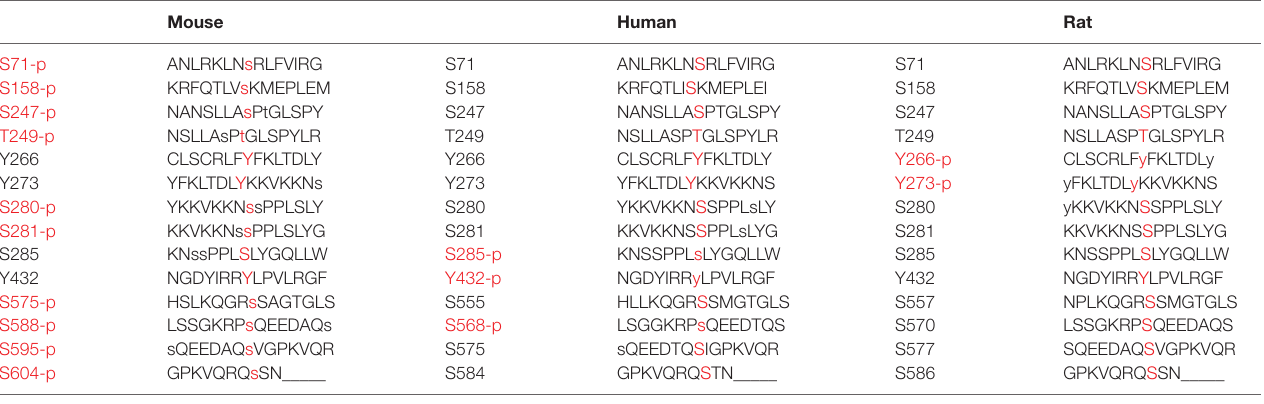
TaBle 1 | Phosphorylated residues of crY1 (mouse, human, and rat) are written in